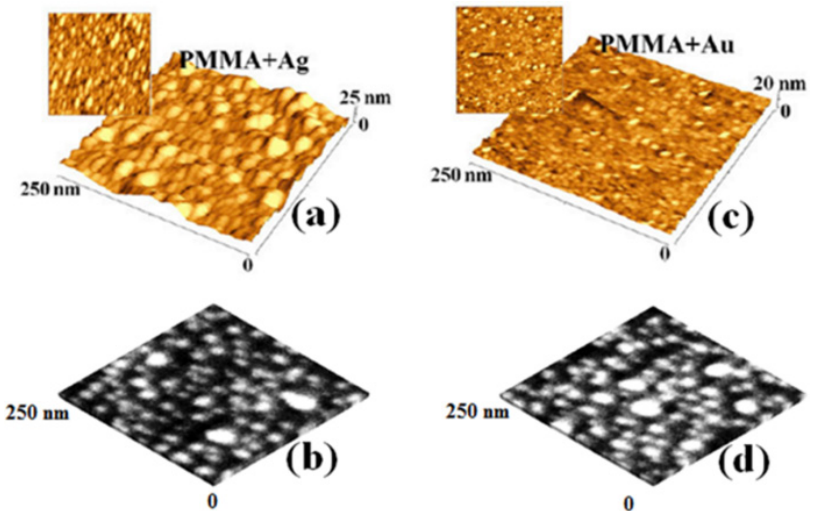
Figure 12. Representative two-dimensional and three-dimensional reconstruction of 0.25 μ m × 0.25 μ m AFM images of Ag ( a ) and Au ( c ) films deposited on PMMA. ( b ) and ( d ) report the correspondent SEM images. (Reproduced with permission from [65], Copyright Springer 2012).